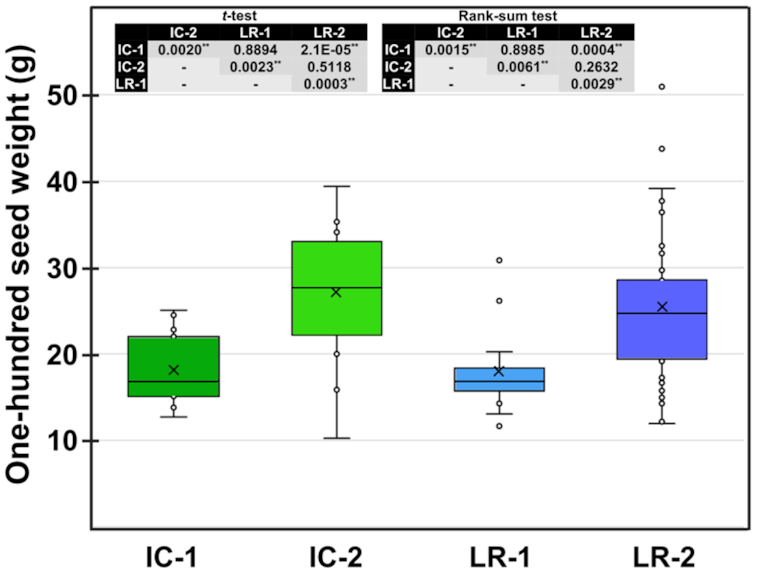
Box plot for 100-SW trait. The tables in this figure show P-values for 2-sample t-test (left) and Wilcoxon rank-sum test (right) calculated for all subgroup pairs. Top and bottom of the box indicate the interquartile range, and their whiskers mean 1.5 × interquartile range. Horizontal line and marker "X" indicate the median and mean values of accessions, and empty circles represent accessions observed outside the interquartile range (see Additional File 2 for phenotype information).